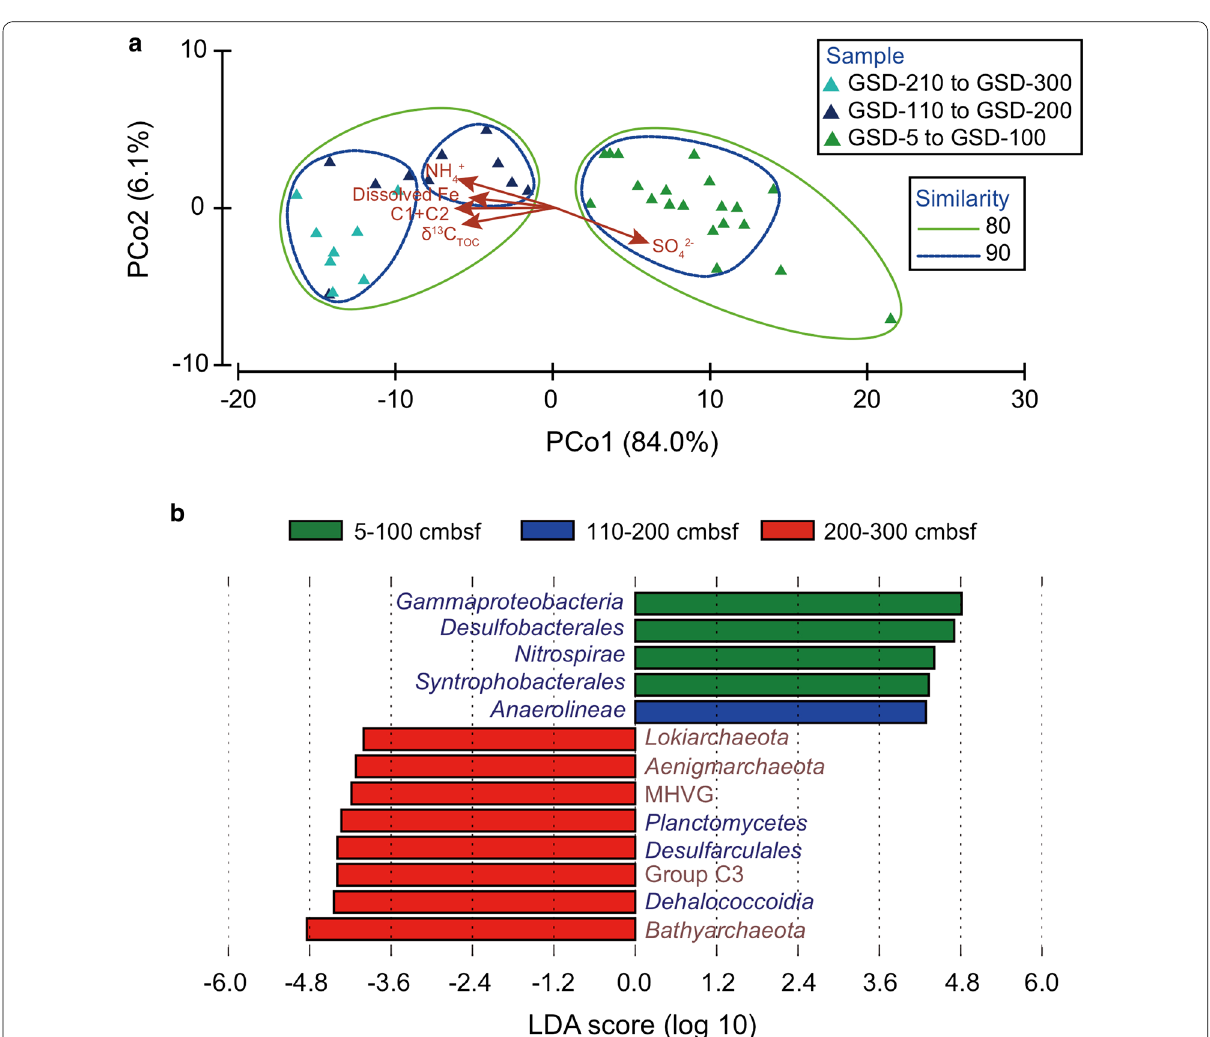
Fig. 4 Principal coordinates analysis (PCoA) ( a ) and linear discriminant analysis (LDA) effect size (LEfSe) of microbial groups ( b ) with a LDA threshold of 3.5. In ( b ), dark red archaeal groups and dark blue bacterial = =